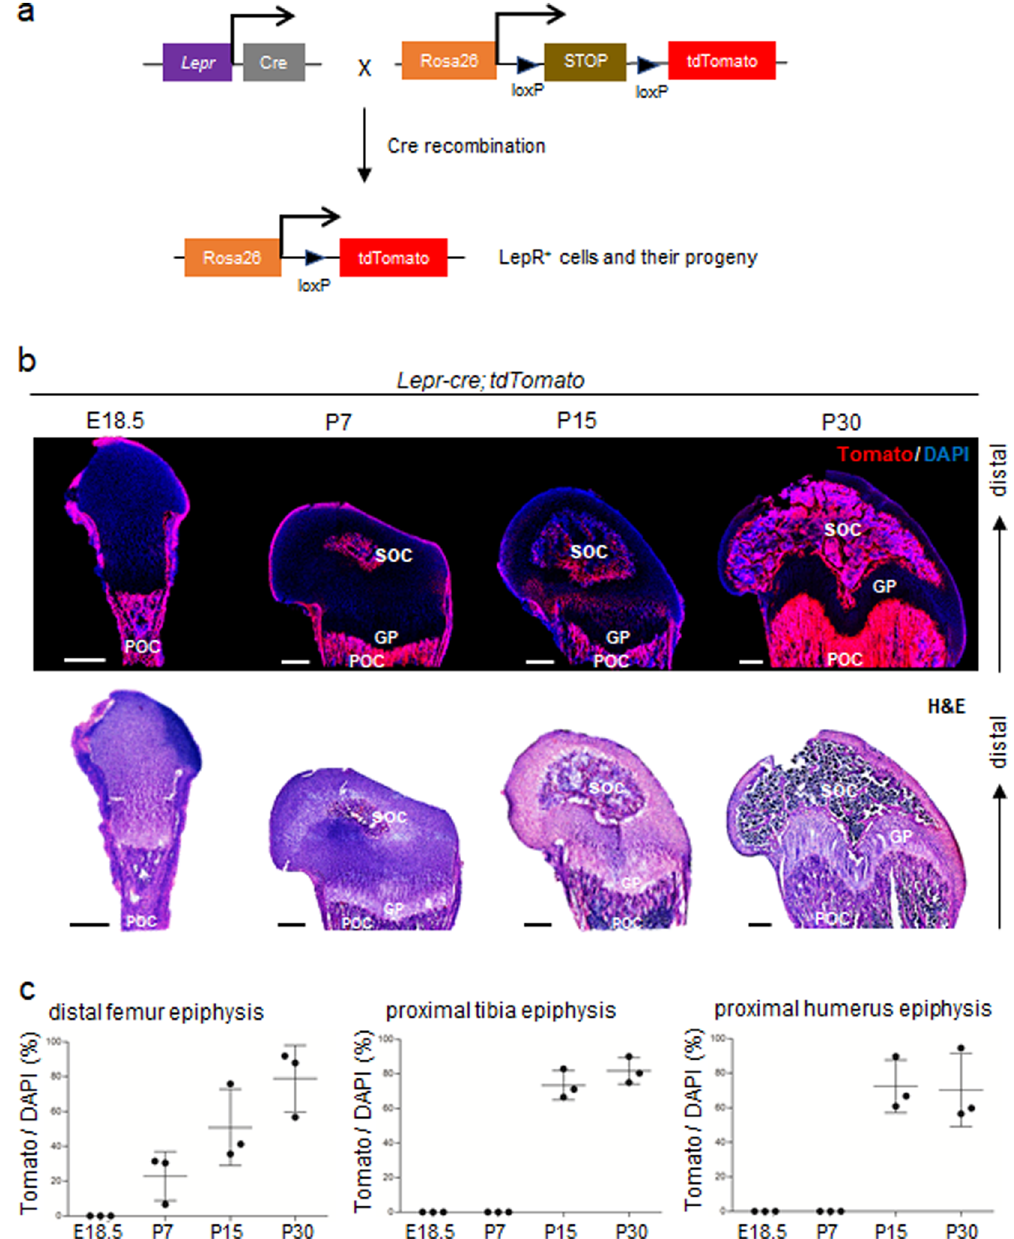
Fig. 1 Fate mapping of LepR + MSCs during embryonic and postnatal growth. a Illustration of in vivo lineage-tracing experiments with Lepr-cre; tdTomato mice. b The POC and SOC in the distal femur of Lepr-cre; tdTomato mice were histologically examined on E18.5, P7, P15 and P30. Representative pictures showing the appearance of Tomato + cells at indicated stages. Tomato + (red) and DAPI (blue). The corresponding H&E stain are right below. GP = Growth plate; POC = Primary ossi fi cation center; SOC = Secondary ossi fi cation center. c The percentages of Tomato + cells in SOC at indicated stages and regions. Scale bar, 300 μ m. n = 3 mice. Data are mean ±